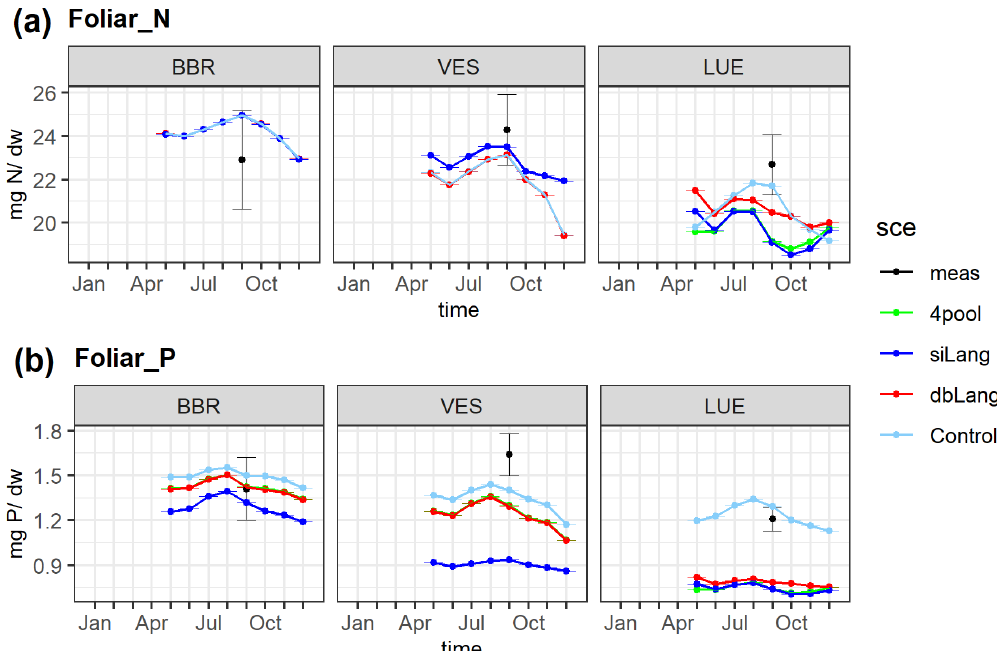
Figure 4. Simulated and measured foliar N (a) and P (b) content along the soil P availability gradient. The simulated values are the yearly average of the 2006–2015 period, and the measured values were sampled in 2014. The black dots are the field measurements, the lime line represents the Langmuir model with only four inorganic P pools (4pool), the blue line represents the single-surface Langmuir model (siLang), the red line represents the double-surface Langmuir model (dbLang), and the light sky-blue line represents the Control